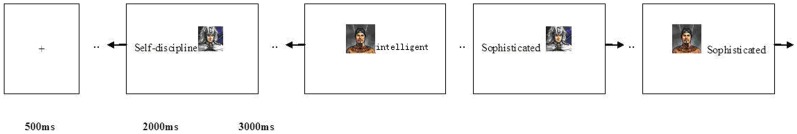
Positive avoidance – negative approach (inconsistent pattern, visual pictures).The Group 4 condition tested an inconsistent pattern based on visual pictures. A picture of the reference object appeared on the screen, and a corresponding personality adjective appeared on either the left or the right side of the picture.